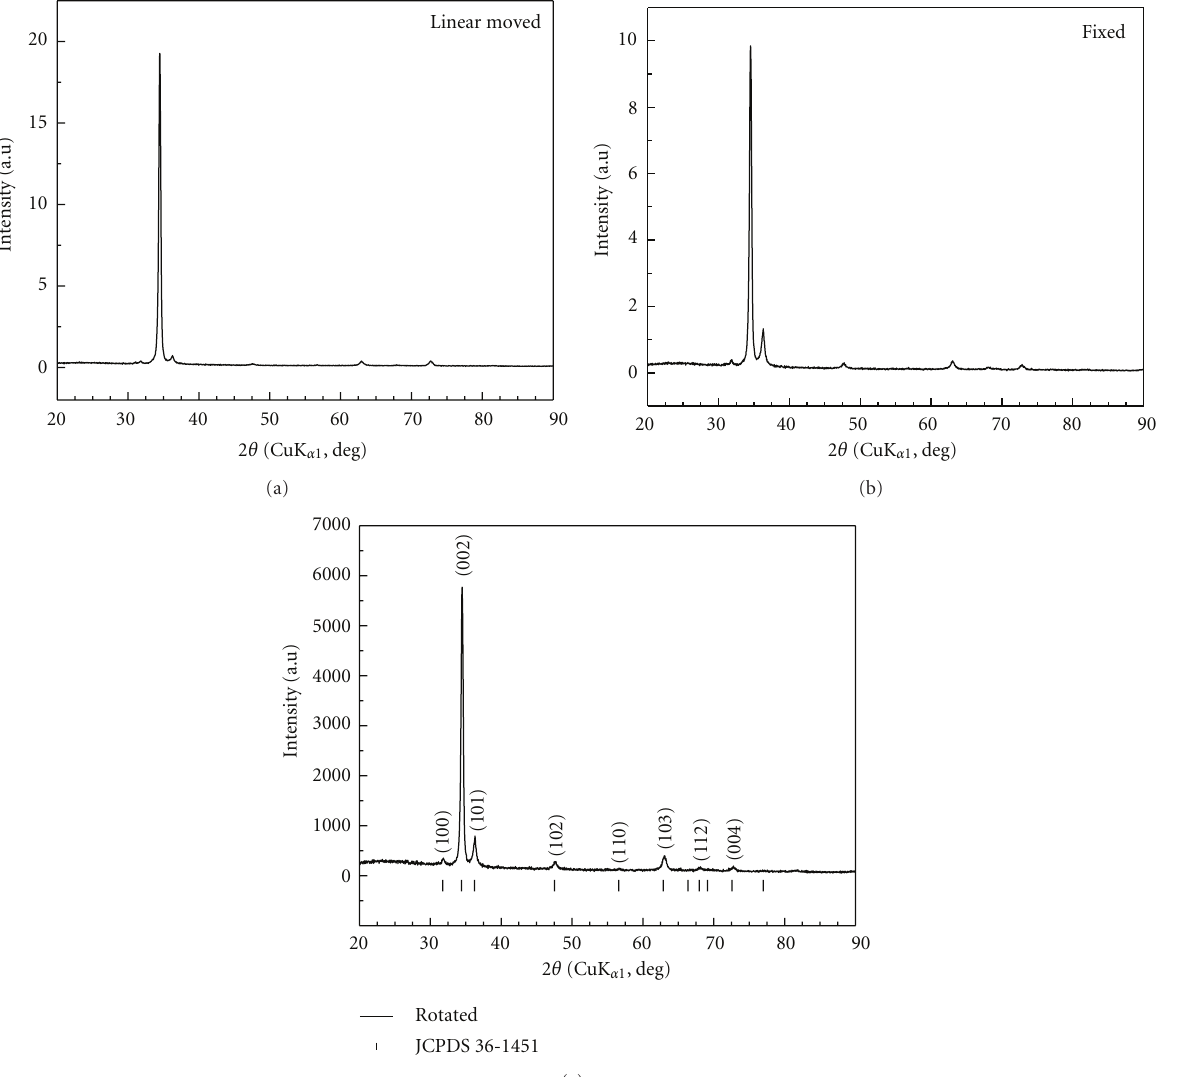
intensities (Figure 5). The highest intensity for (002) peak was observed for ZO1 sample, the lowest peak intensity was observed for ZO3 sample. The decrease of peak intensity is correlated with the decrease of the film